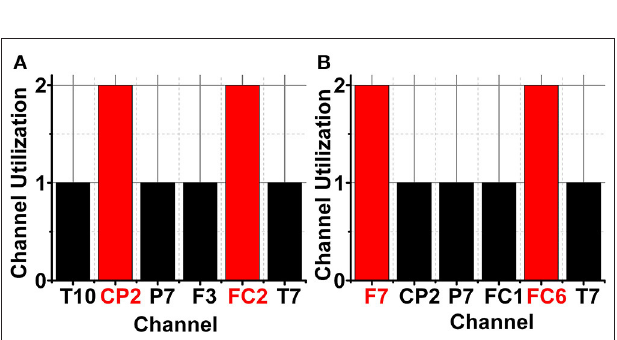
FIGURE 10 | ODU data set channel importance for ASD classification (A) LSFE matrix (B) SKB and